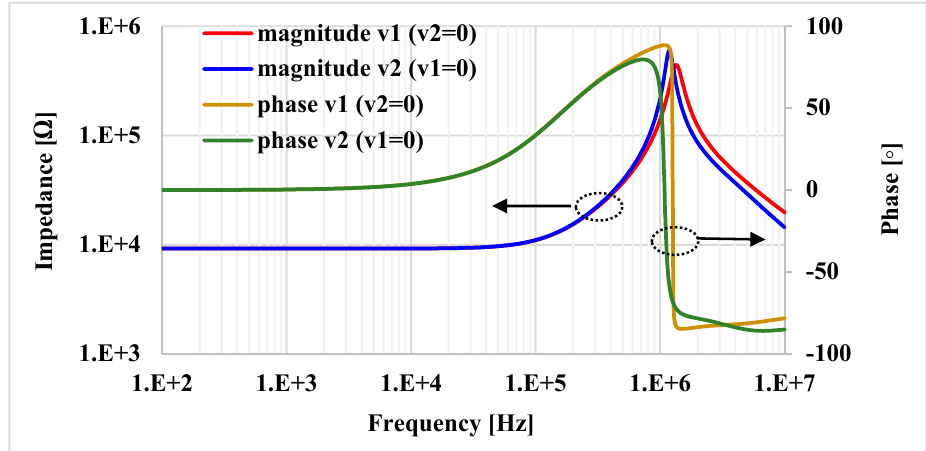
resistance simulator with R set = 10 k Ω is shown in Figure 21. The simulated inductance and resistance values are about 12.39 mH and 9.22 k Ω , respectively. The impedance of the floating series L-R for different values of R set is shown in Figure 22, where R set had four values (10, 20, 30, and 40 k Ω ). The inductance values simulated from these R set values were 12.39, 23.38, 30.92 and 35.29 mH, respectively. Additionally, the resistance values simulated from these R set values were 9.22, 16.88, 23.41, and 29.04 k Ω , respectively. The simulation performed on the floating parallel inductance-resistance simulator is shown in Figure 23. The simulated inductance and resistance values were about 11.28 mH and 9.43 k Ω , respec- tively. The impedance of the floating parallel L-R for different values of R set is shown in Figure 24, where R set was changed to four values (10, 20, 30, and 40 k Ω ). The inductance values simulated from these R set values were 11.28, 21.48, 30.81, and 39.41 mH, respectively. Furthermore, the resistance values simulated from these R set values were 9.22, 17.36, 24.08, and 29.79 k Ω , respectively. 24.08, and 29.79 k Ω , respectively.